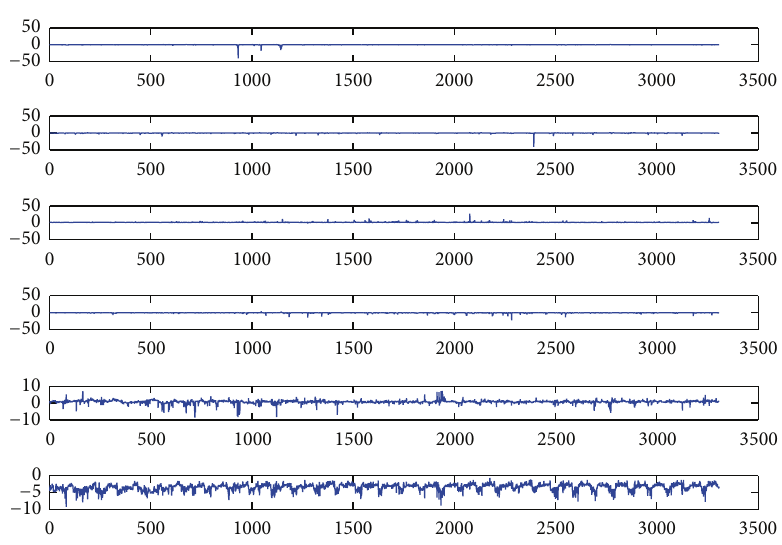
Figure 5: Oscillogram of the data separated by the